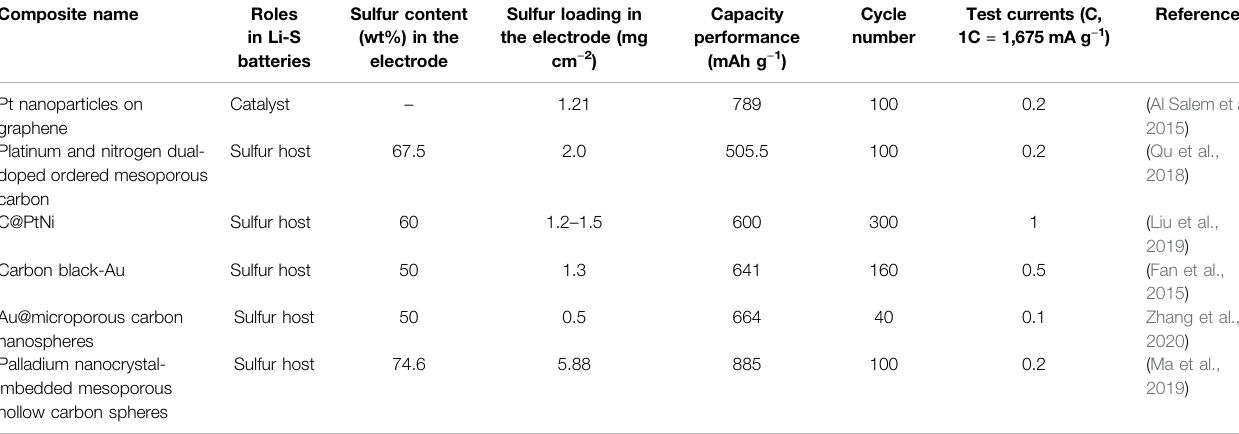
TABLE 1 | Various noble metal atom-decorated carbon materials for enhancing the performances of Li-S